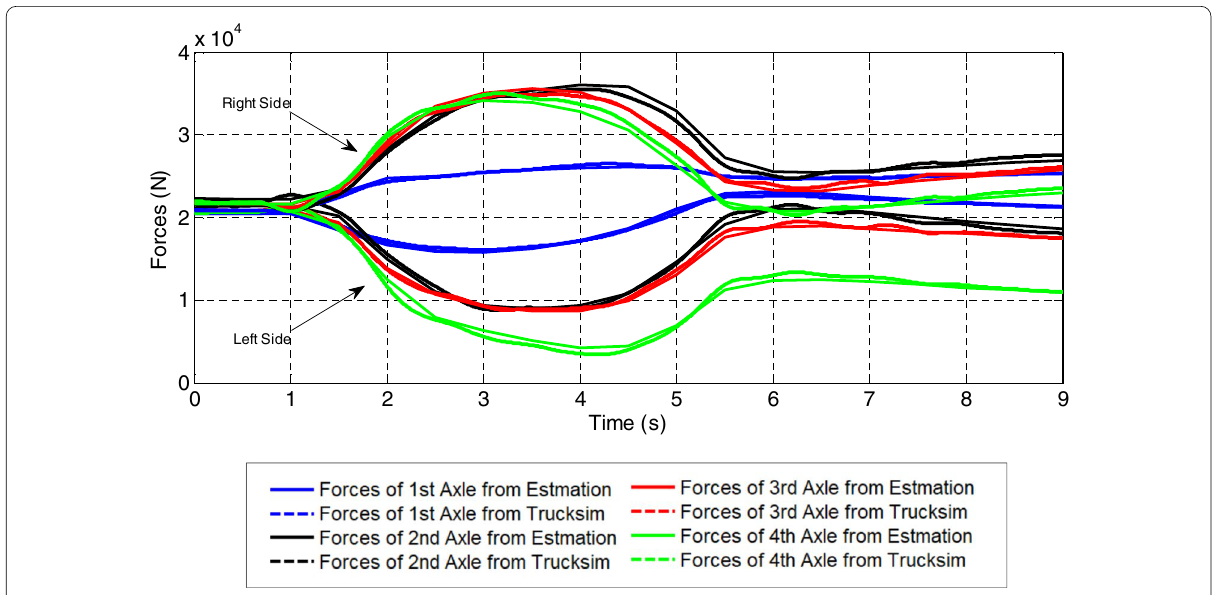
Figure 12 Vertical tire forces from estimation with adjustment under Condition 4 without